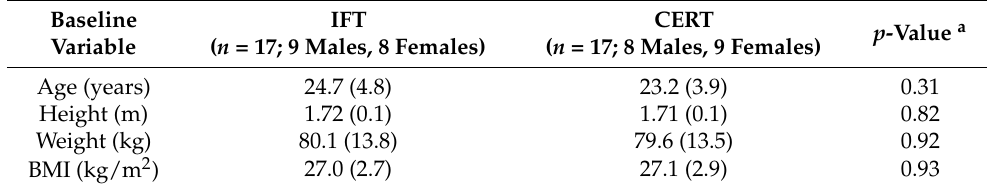
Table 2. Participant baseline